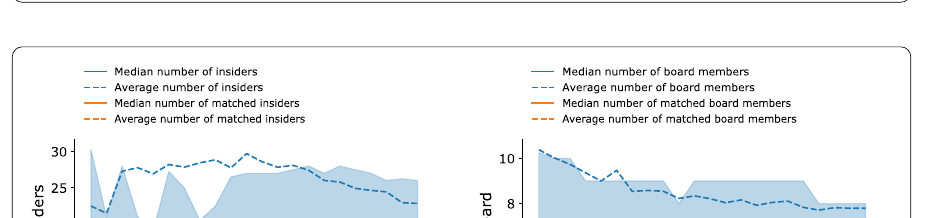
Figure 9 Daily number of company insiders, matched insiders, board members, and matched board members. Solid lines represent insiders, while the dashed lines mark company board members. Grey bands mark two periods of SIRE data set. The difference between the blue and the orange solid (dashed) curves indicates the number of insiders (board members) that did not trade shares of their own securities during the observed period, i.e. the number of insiders and board members for which we had no data in order to match them with a trading account from the SRD data set. The difference is smaller when looking only at board members. This means that there are fewer unmatched board members than other kinds of unmatched insiders